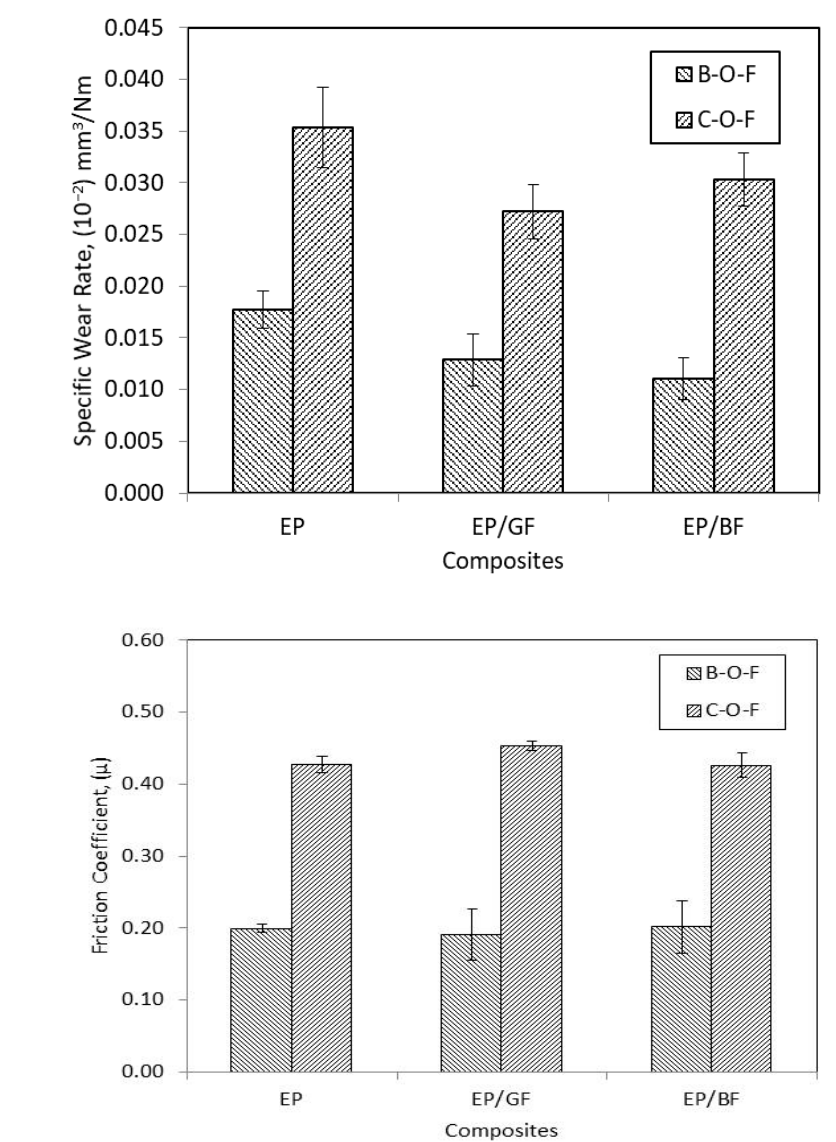
Figure 7. ( a ) Specific wear rate and ( b ) friction coefficient of pure epoxy and its composites under B-O-F and C-O-F configuration of reciprocating sliding.